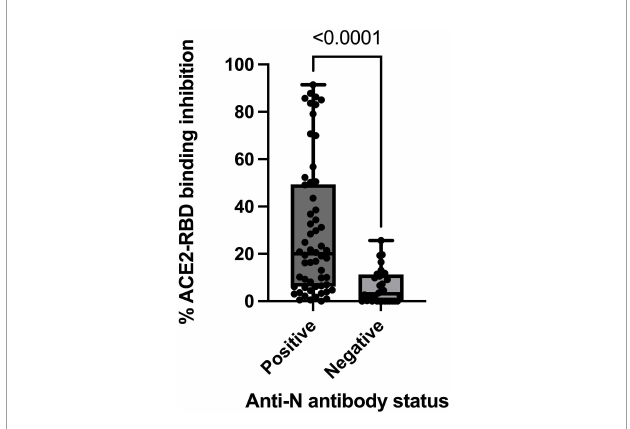
FIGURE2 ACE2-RBD protein-protein binding inhibition stratified by participant anti-nucleocapsid antibody status for total sub-cohort ( n =